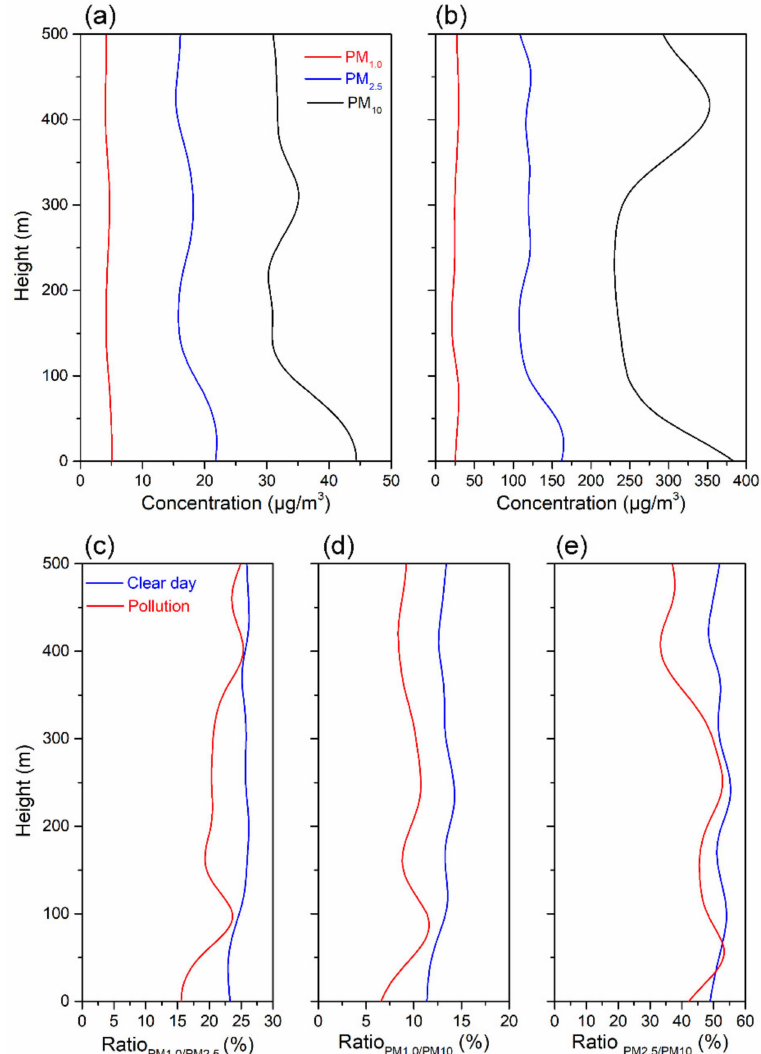
Figure 7. Comparison of the dust concentration between clear days ( a ) and pollution days ( b ); and the concentration ratio of ( c ) PM 1.0 /PM 2.5 , ( d ) PM 1.0 /PM 10 , ( e ) PM 2.5 /PM 10 in TZ during the observation